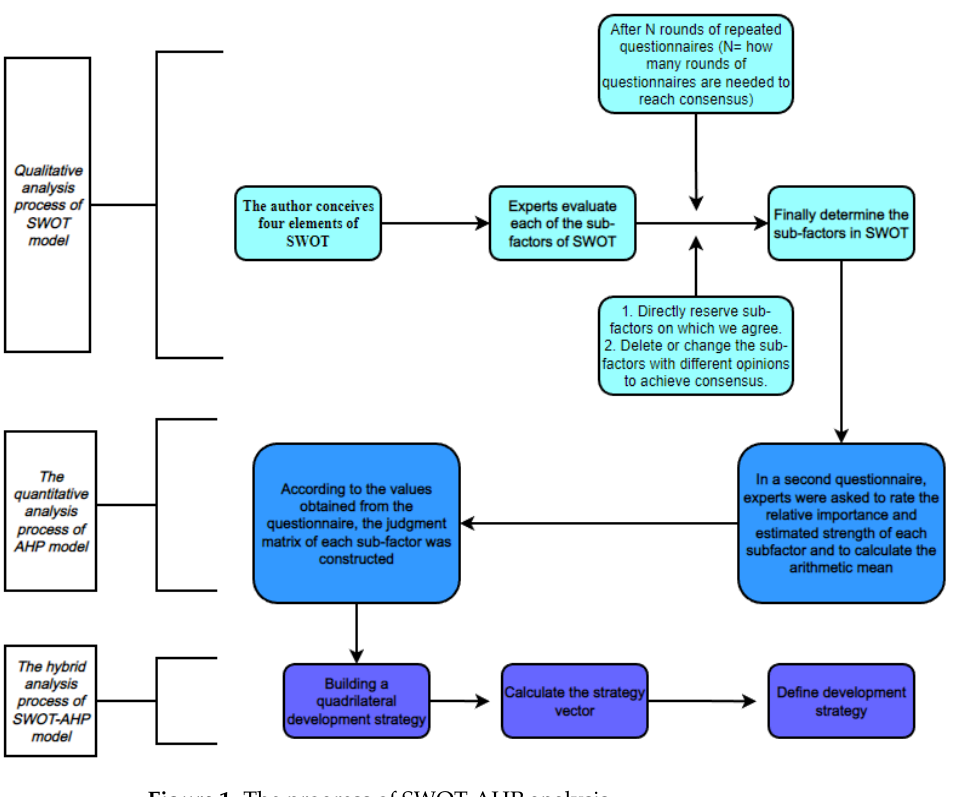
Figure 1. The progress of SWOT-AHP analysis.